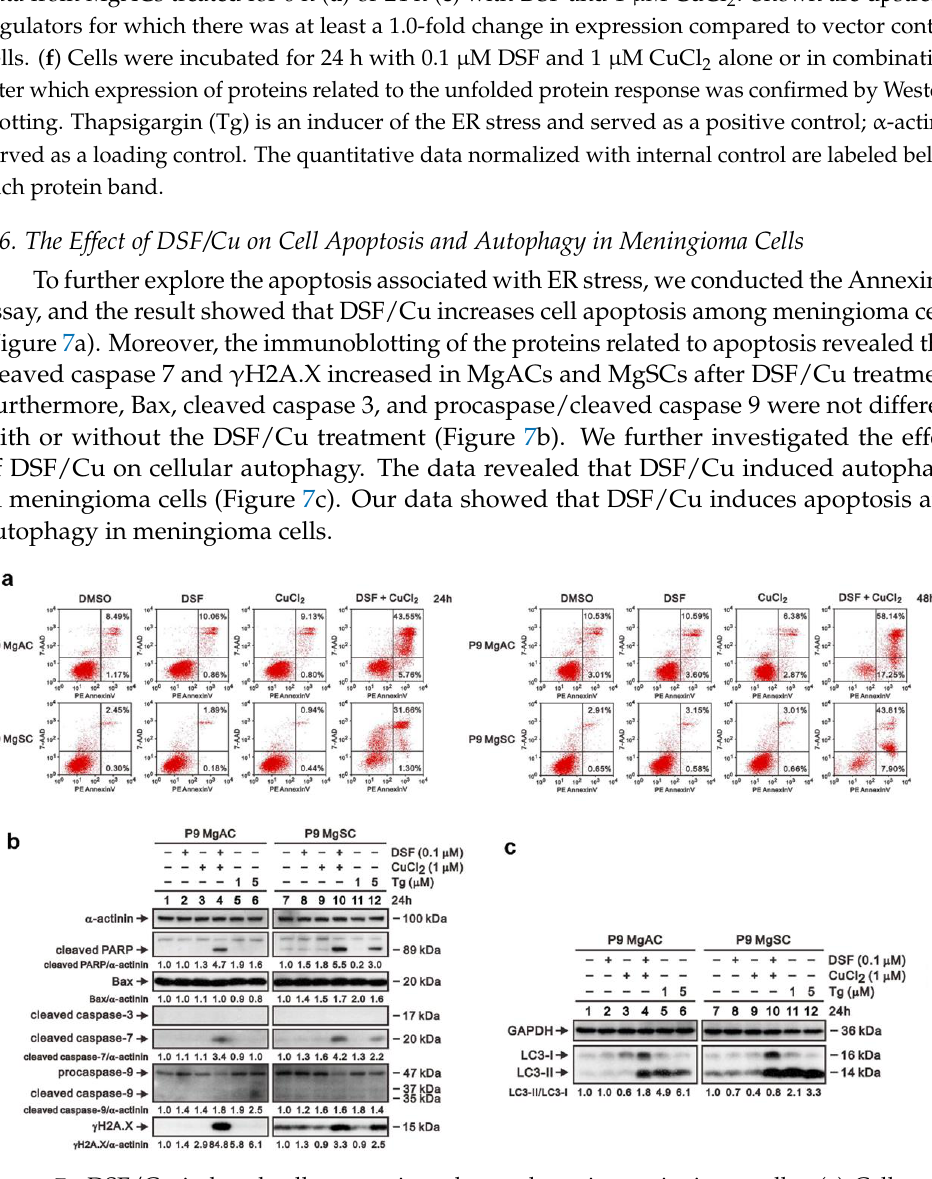
Figure 7. DSF/Cu induced cell apoptosis and autophagy in meningioma cells. ( a ) Cells were incubated for 24 h or 48 h with 0.1 µ M DSF with or without 1 µ M CuCl 2 . Cell apoptosis was analyzed based on flow cytometric analysis of Annexin V staining. Cells were incubated for 24 h with 0.1 µ M DSF and 1 µ M CuCl 2 alone or in combination, after which expressions of proteins related to apoptosis ( b ) and autophagy ( c ) were evaluated by Western blotting. Thapsigargin (Tg) served as a positive control; α -actinin served as a loading control. The quantitative data normalized with internal control are labeled below each protein